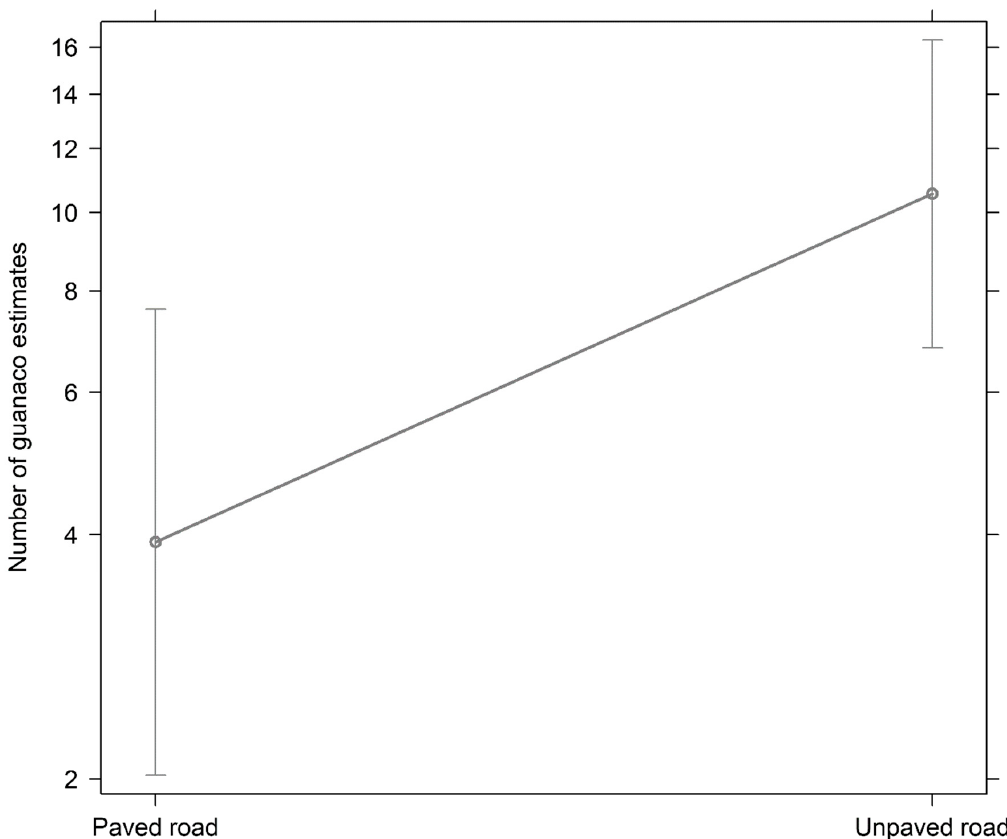
Figure 2. Mean and standard deviation of number of guanacos estimated of modelling by camera traps in relation to different kinds of roads.